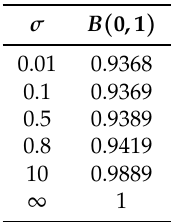
Table 6. Bond price B ( 0,1 ) .